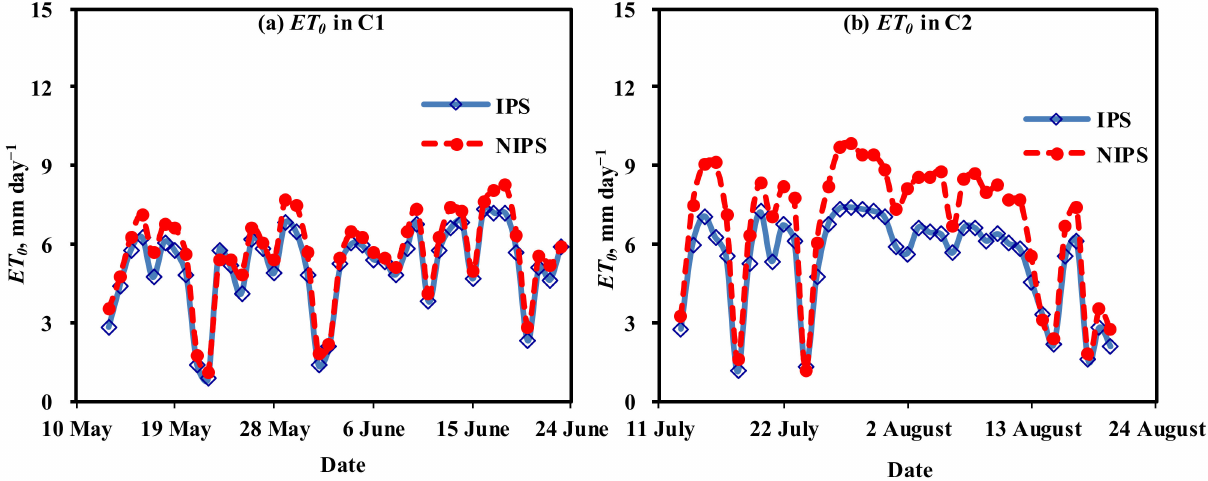
Figure 7. Changes of ET 0 under the IPS and NIPS treatments during C1 ( a ) and C2 ( b ) of CFC.